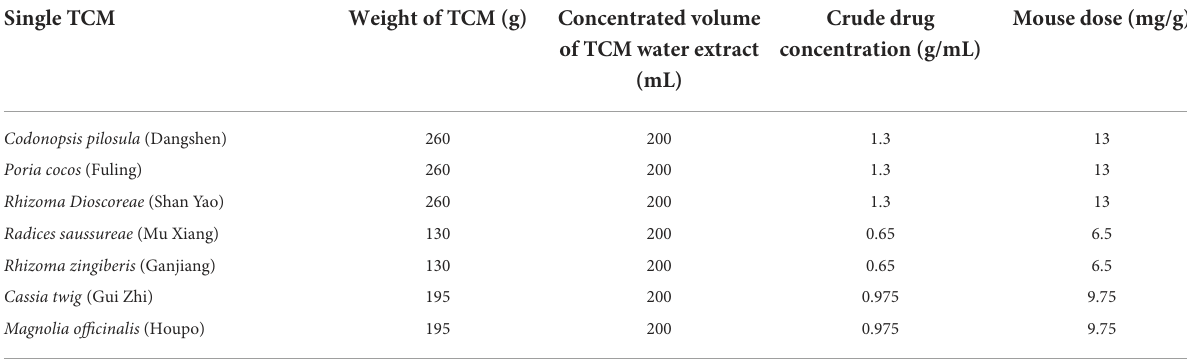
TABLE 1 Single TCM gavage dose for mouse treatment. Single TCM Weight of TCM (g)